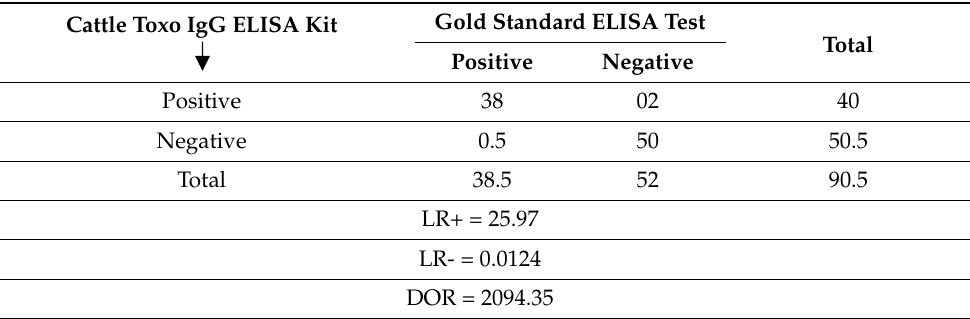
Table 8. Performance of Cattle Toxo IgG ELISA kit relative to Standard ELISA kit for the detection of anti- T. gondii IgG ( n = 90). Table 9. Calculation of Likelihood ratio for a positive-test-outcome ratio (LR+), Likelihood ratio for a negative-test-outcome (LR-), and Diagnostic Odd Ratio (DOR) of our new Cattle Toxo IgG ELISA kit Table 7. Calculation of sensitivity and specificity of Latex Agglutination kit against Cattle Toxo IgG against Gold Standard ELISA kit (Commercial ELISA kit). ELISA kit ( n =